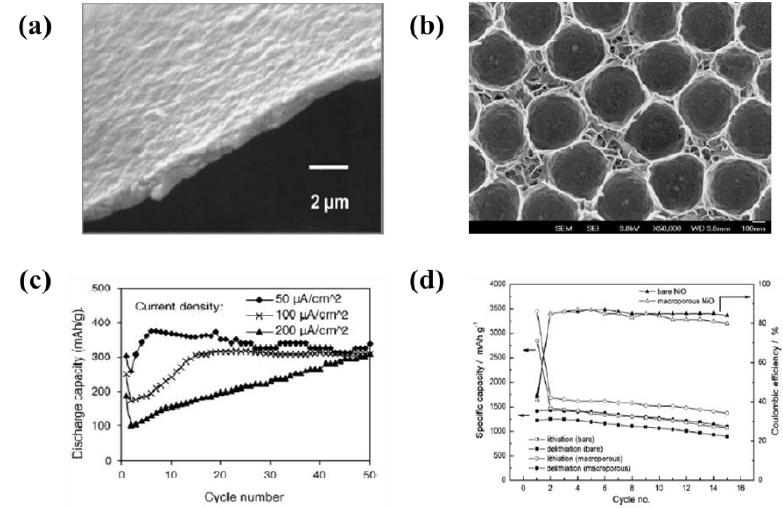
Figure 12. ( a ) SEM image of the V 2 O 5 film prepared by EPD; ( b ) SEM image of a macroporous NiO film; ( c ) Cycling performance of V 2 O 5 films prepared by EPD; ( d ) Cycling performance of a macroporous NiO film.